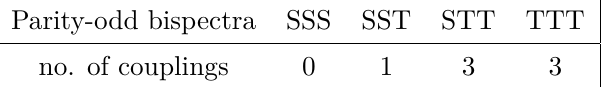
Table 2. For manifestly local and scale invariant theories, the table specifies the number of inde- pendent parity-odd tree-level bispectra for all possible combinations of scalars (“S”) and gravitons (“T”) to all orders in